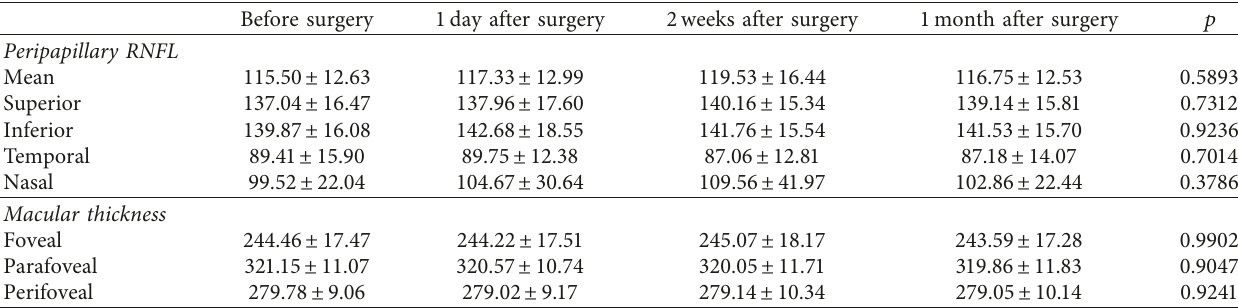
Table 3: Peripapillary RNFL and macular thickness values before and after surgery ( μ m). Before surgery 1day after surgery 2weeks after surgery 1month after